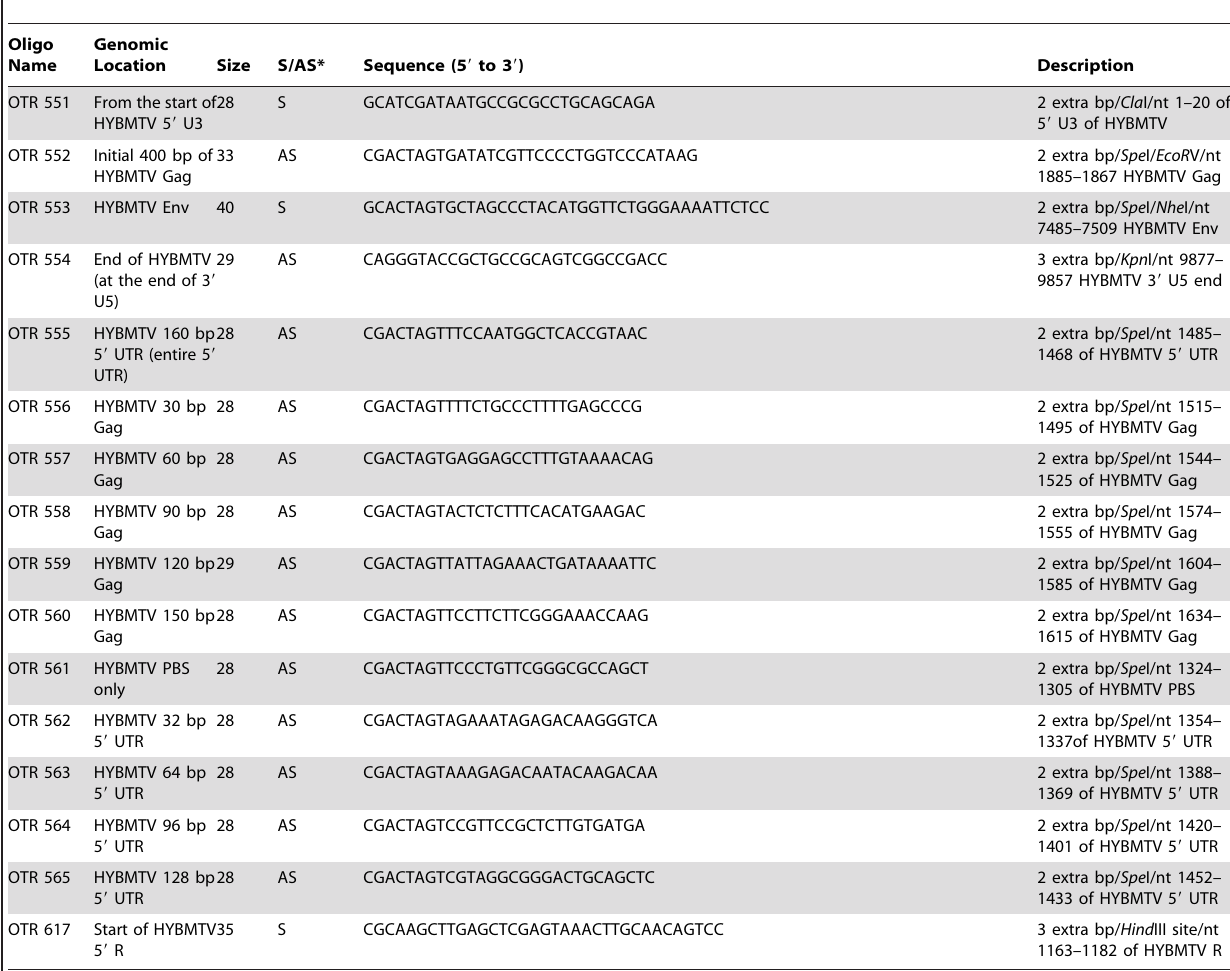
Table 2. Description of primers used for cloning of the DA, FA, and NS series of vectors, with either the MMTV LTR or the chimeric 5 9 LTR containing